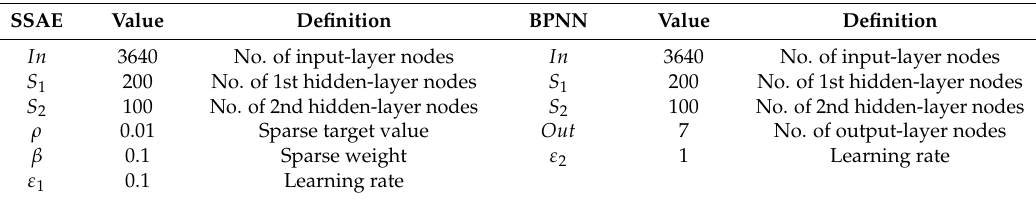
Table 2. Parameters setting up of SSAE-BPNN.